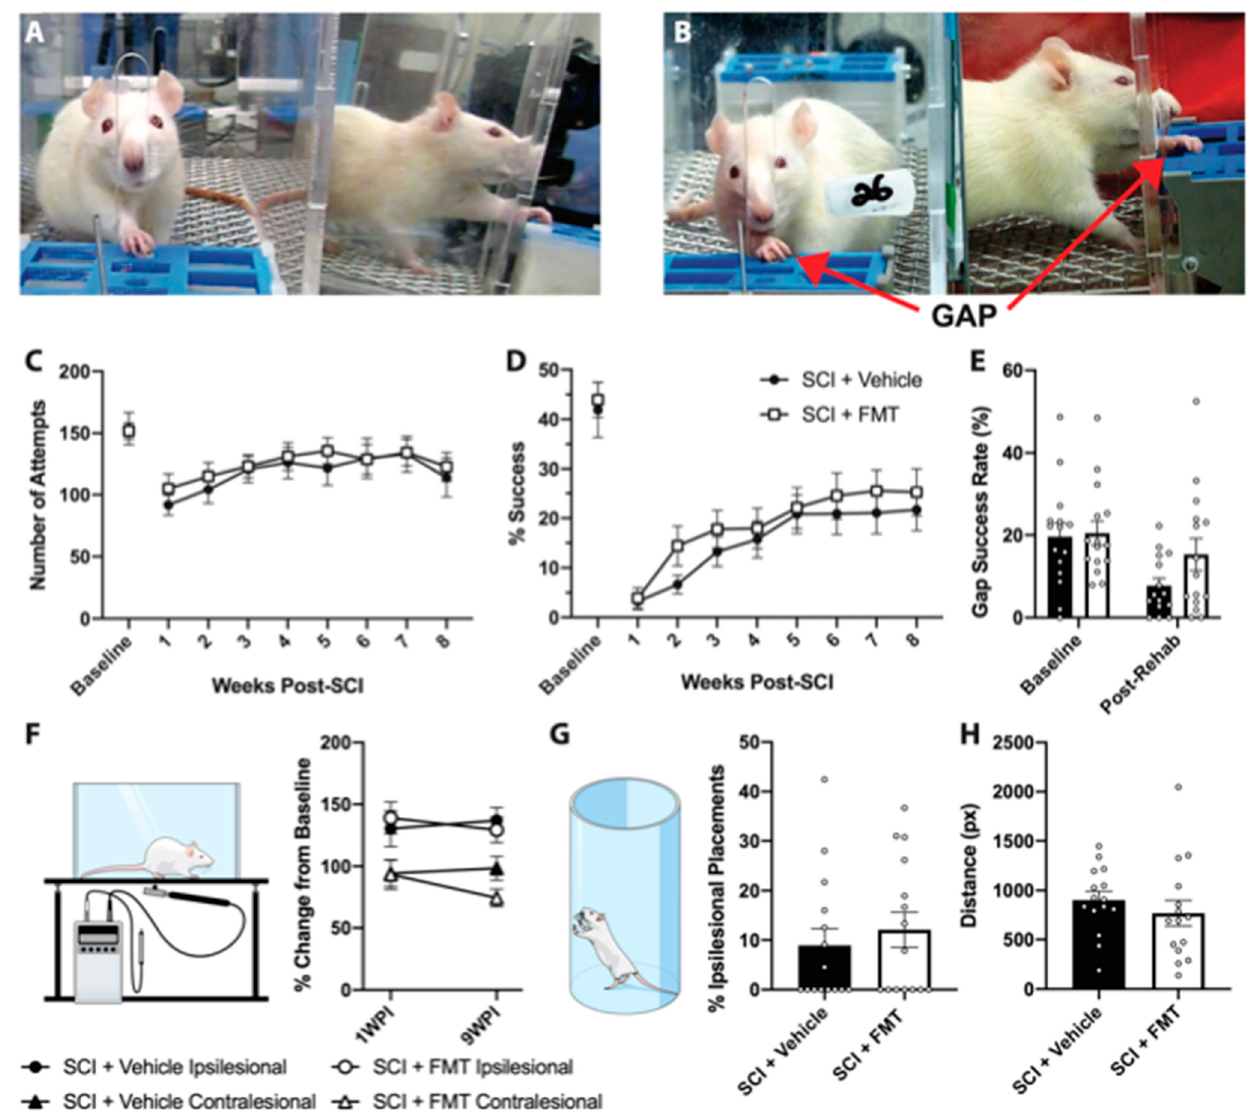
Figure 4. FMT from anxious rats did not significantly affect motor recovery following spinal cord injury. ( A ) Image of a rat in the regular single pellet grasping apparatus, reaching through a narrow opening for a food pellet. ( B ) Image of a rat reaching in the single pellet grasping apparatus that has been modified to include a gap between the pellet and the opening of the chamber (to eliminate compensatory pellet scooping behaviour). ( C ) There was no difference between FMT and vehicle groups in the number of attempts or ( D ) the success rate in rehabilitative training. ( E ) The success rate in the modified gap task was measured once at baseline and again at the end of the rehabilitation period. There were no significant differences between FMT and vehicle treated groups in the von frey test (quantified as the force required to elicit a withdrawal response, expressed as a percentage of baseline values) ( F ) the cylinder test ( G ) or the distance travelled in the open field ( H ). Error bars represent standard error mean.